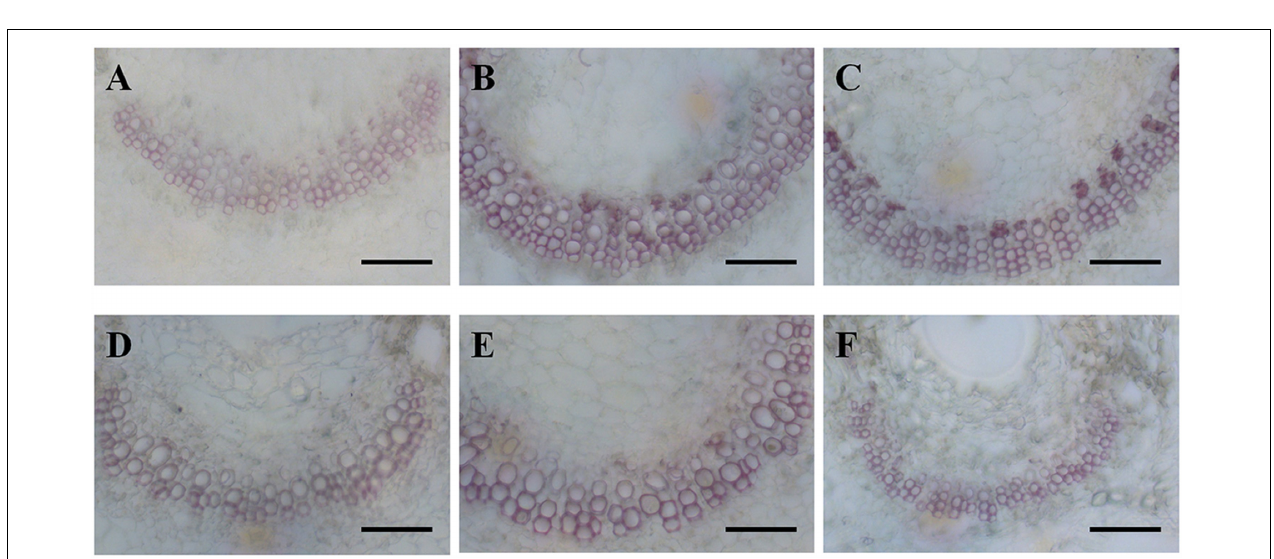
FIGURE 5 | Phloroglucinol-HCl staining of leaf midvein sections from diploids (A, 80% FC; B, 50% FC; C, 20% FC) and hexaploids (D, 80% FC; E, 50% FC; F, 20% FC). Scale bars are 50 µ